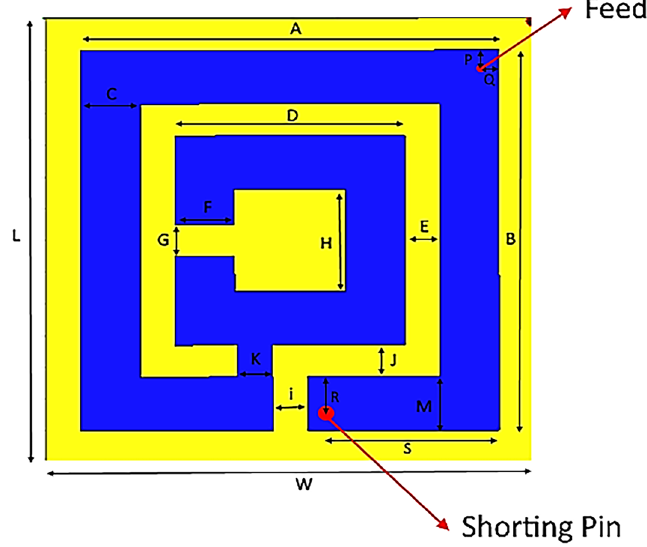
Figure 1. The proposed antenna configuration and dimensions.